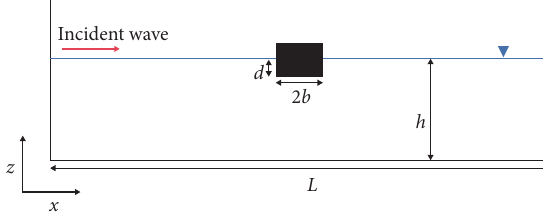
Figure 8: Schematic of the numerical wave flume.